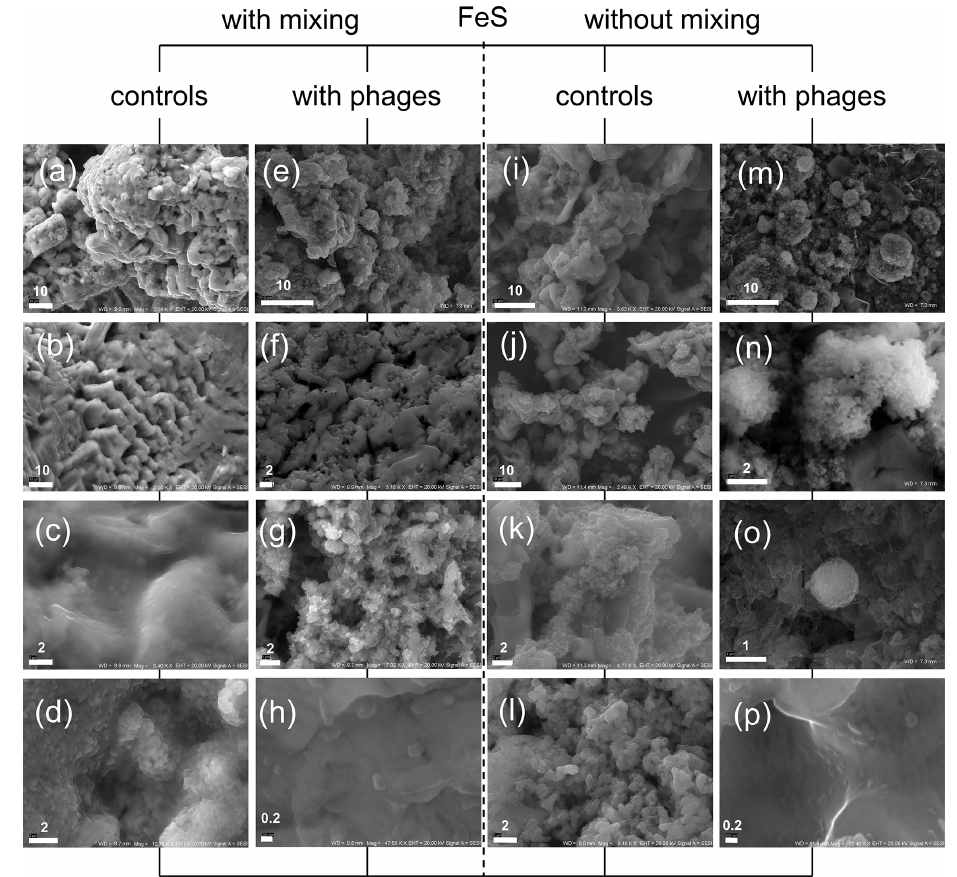
Figure 6. FeS precipitates under SEM after experiments with and without P1 bacteriophages. (a–d) Minerals precipitated without bacterio- phages under mixing conditions; (e–h) mineral structures obtained in experiment with bacteriophages under mixing conditions; (i–l) minerals precipitated without bacteriophages under static (without mixing) conditions; (m–p) minerals precipitated with bacteriophages under static conditions; (m) and (o) show spherical structures resembling protoframboids. Bar indicates scale in micrometres